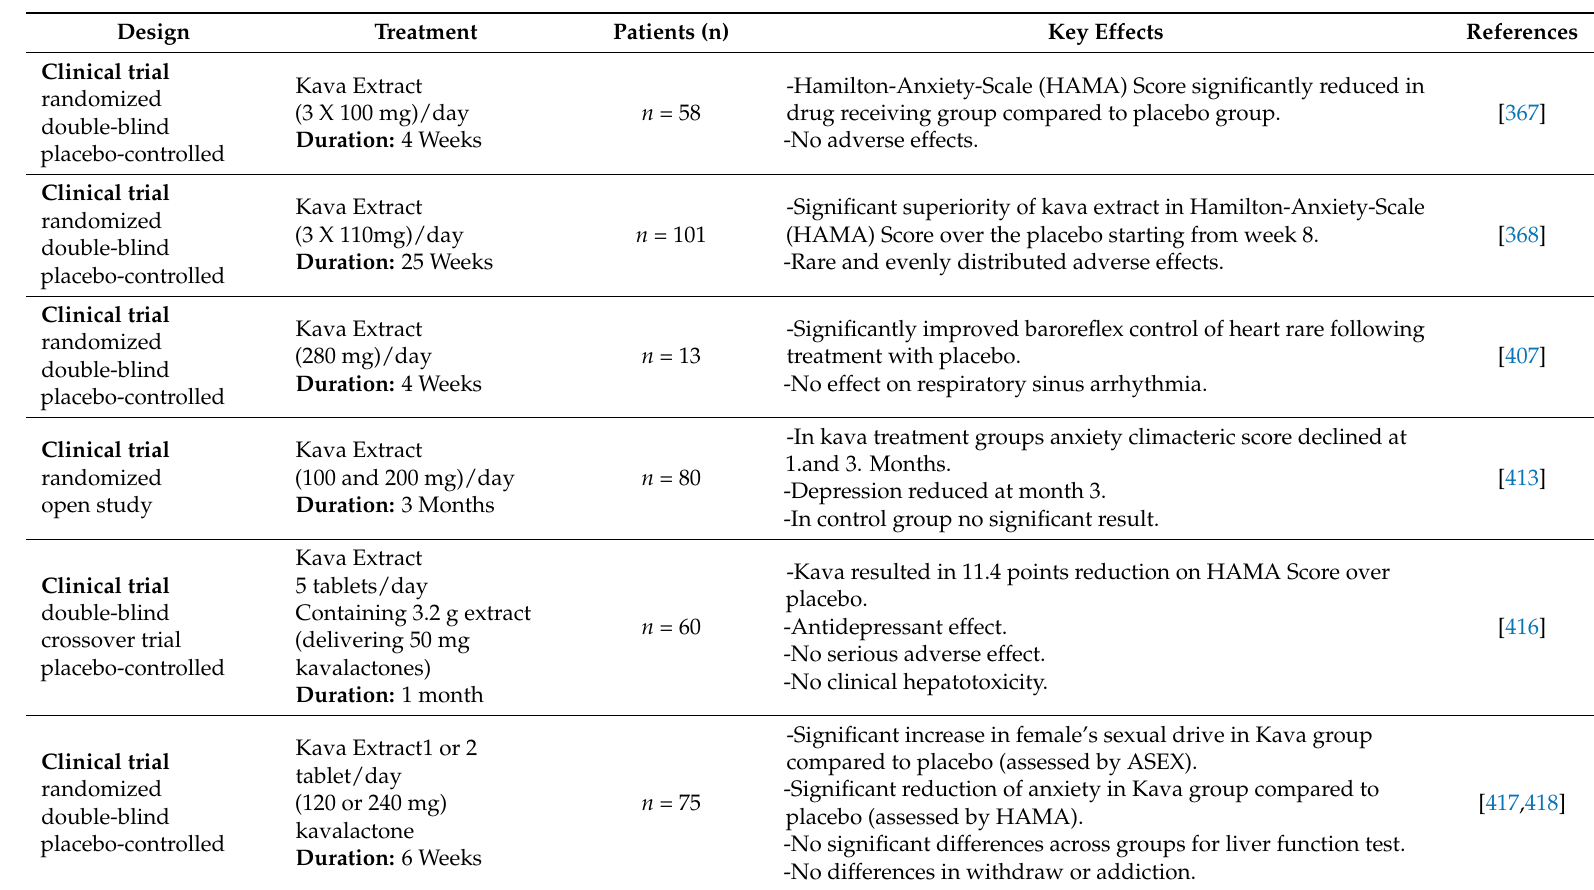
Table 34. Clinical trials on patients with generalized anxiety